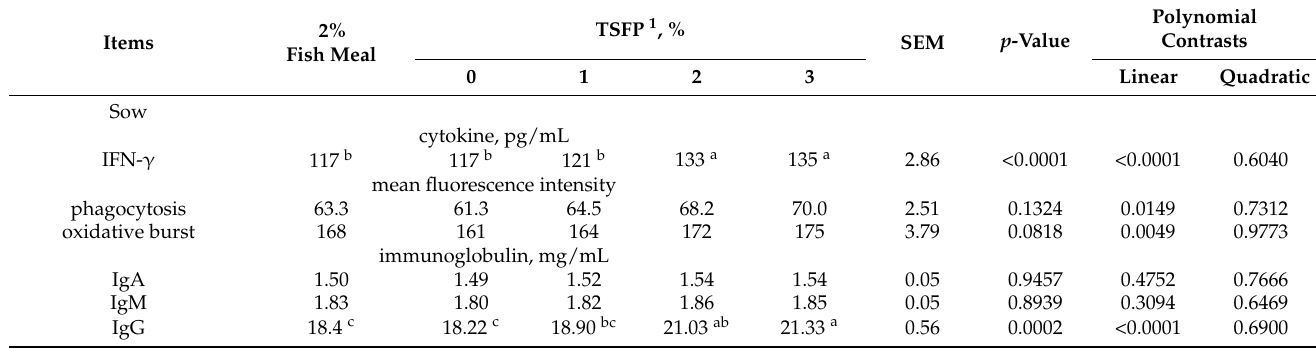
Table 5. The effects of two-stage fermented product on immune characteristics of sow and their piglets during lactation